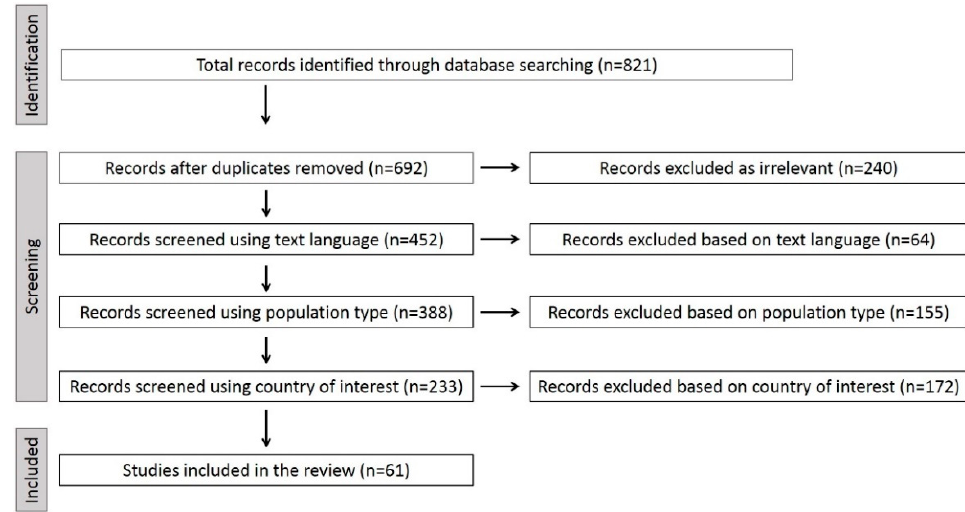
Figure 2. The study selection diagram showing the flow of documents through the literature review.